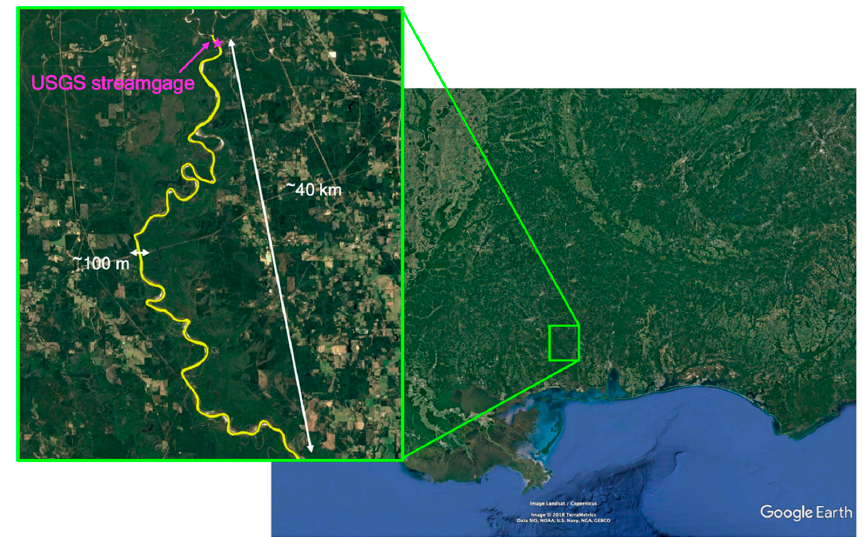
Figure 3. Google Earth imagery of southern Pascagoula River in Mississippi. The location of the USGS